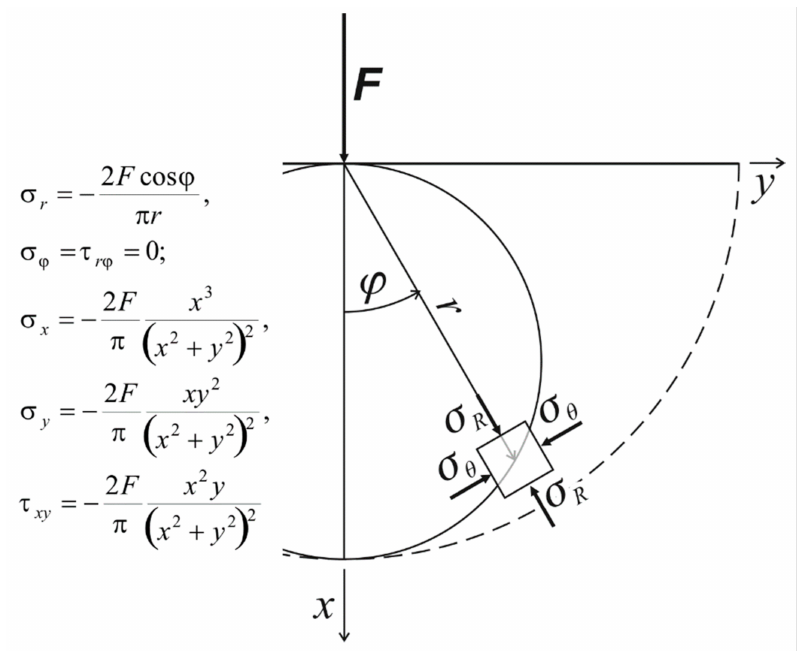
Figure 3. Flamant solution in the stress space in Cartesian and cylindrical systems. Stresses for unit thickness of the disc [6].